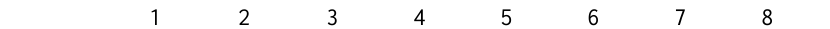
Correlation matrix of the burnout